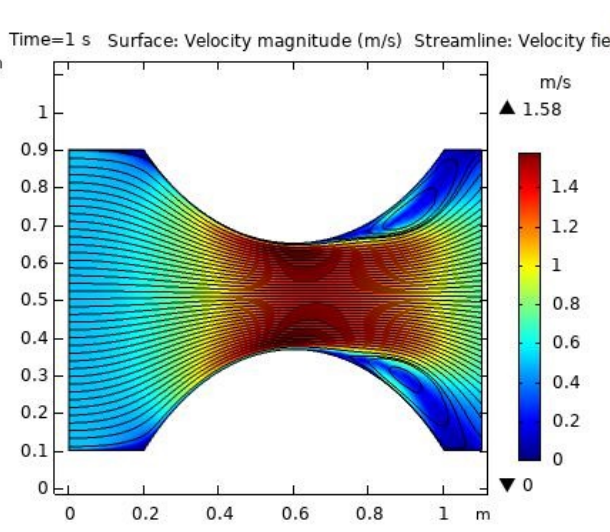
Figure 22. The streamlines at t = 1 s.